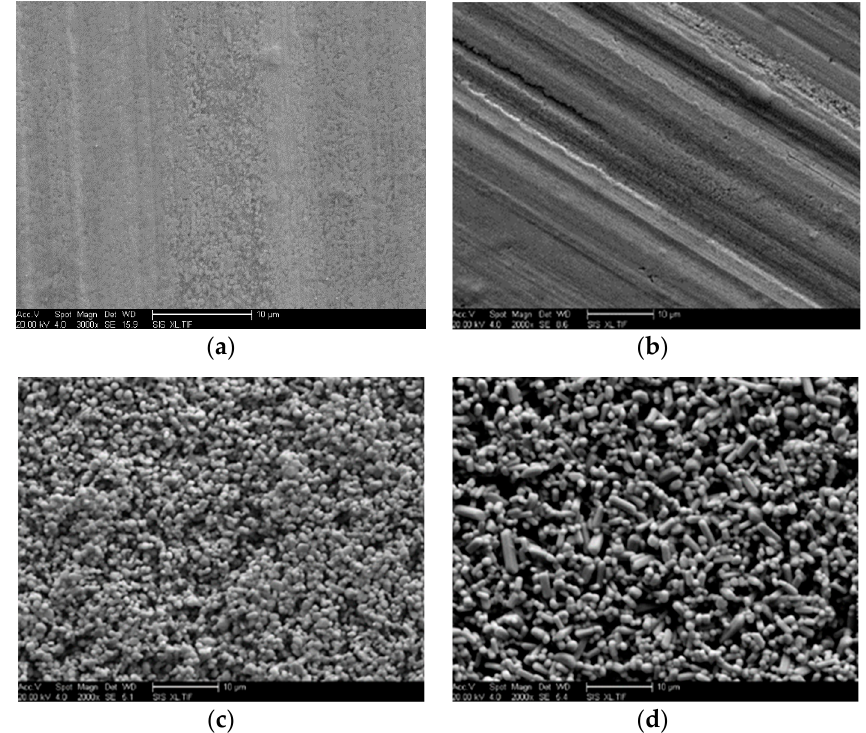
Figure 6. Oxidation morphology of WC/Co at different temperatures: ( a ) room temperature ( b ) 873 K, ( c ) 1173 K, and ( d ) 1273 K.